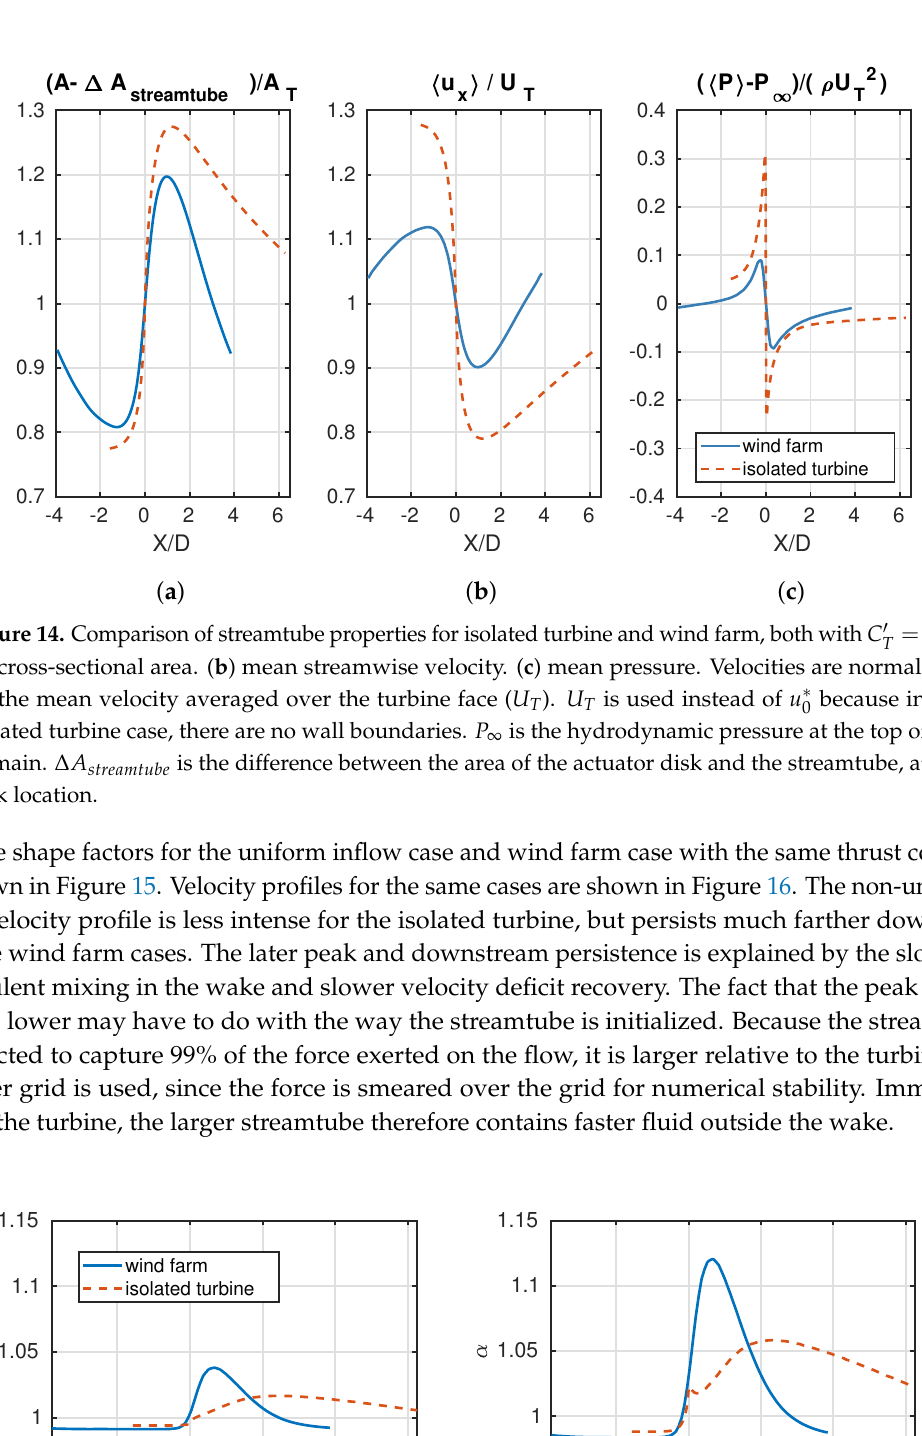
Figure 15. Comparison of shape factors for isolated turbine and wind farm, both with C (cid:48) ( a ) mean streamwise momentum flux shape factor β . ( b ) mean kinetic energy flux shape factor α